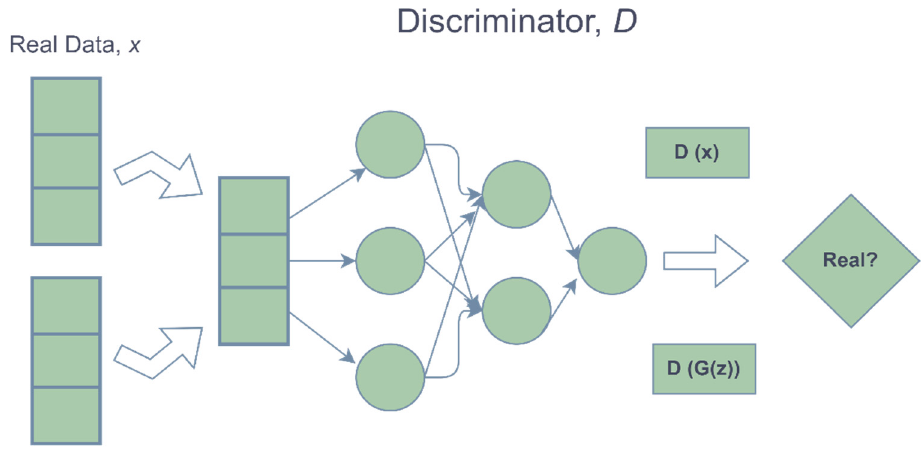
Figure 5. GAN Figure 5. GAN Discriminator.